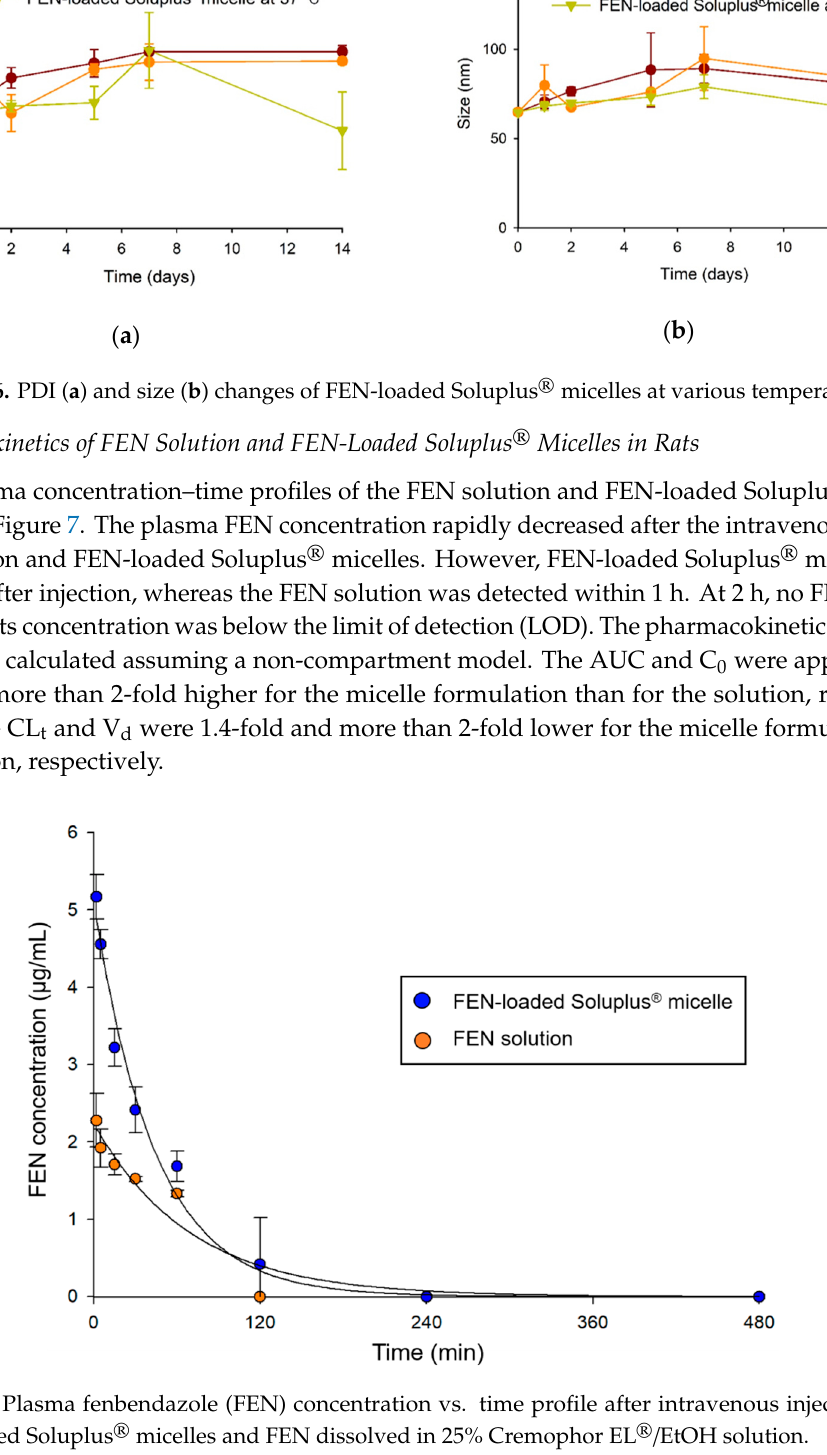
( b ) Figure 4. In vitro MTT assay results for the ( a ) free fenbendazole (FEN) drug and ( b ) FEN-loaded Soluplus ® micelle treatments of the A549 human non-small cell lung cancer (NSCLC) cell line. 3.4. Clonogenic Assay We performed a clonogenic assay to determine the long-term inhibitory efficacy of the treatments against cell reproduction. The cells formed no colonies at 1740 µM. Colony formation was slightly suppressed in the micelle-treated group at 174 µM. Above 17.4 µM, colony formation was not significantly inhibited (Figure 5). Figure 5. In vitro clonogenic assay of free fenbendazole (FEN)- and FEN-loaded Soluplus ® micelle-